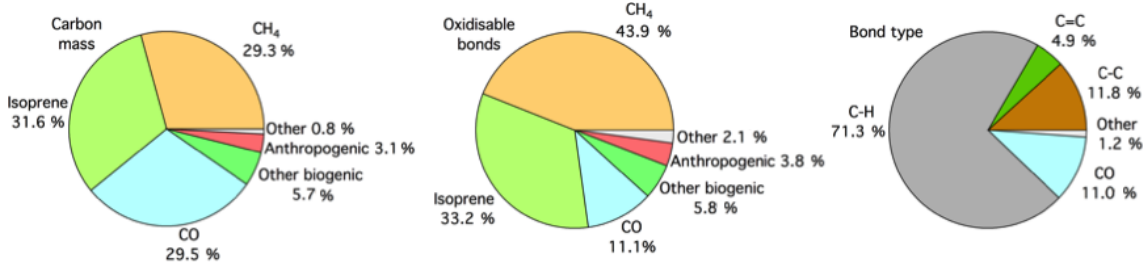
Figure 3. Pie charts showing hydrocarbon emissions in the base GEOS-Chem simulation. Emissions split by carbon mass (left), number of oxidisable bonds (centre), and bond type